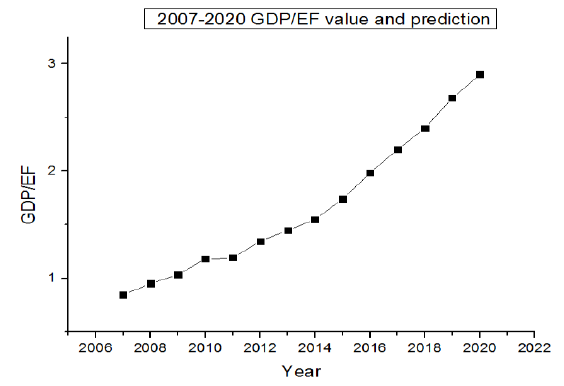
Figure 9. 2007 total ecological deficit of Henan